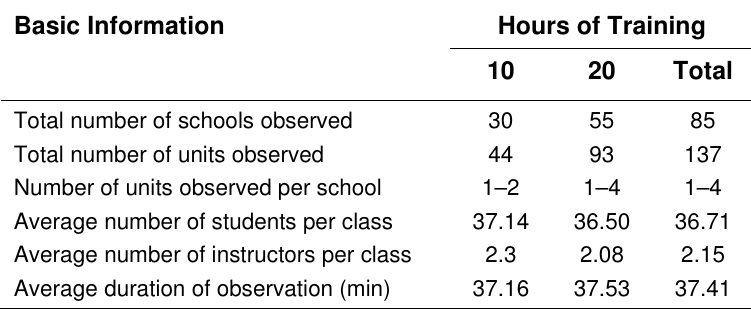
Basic Information of Observed